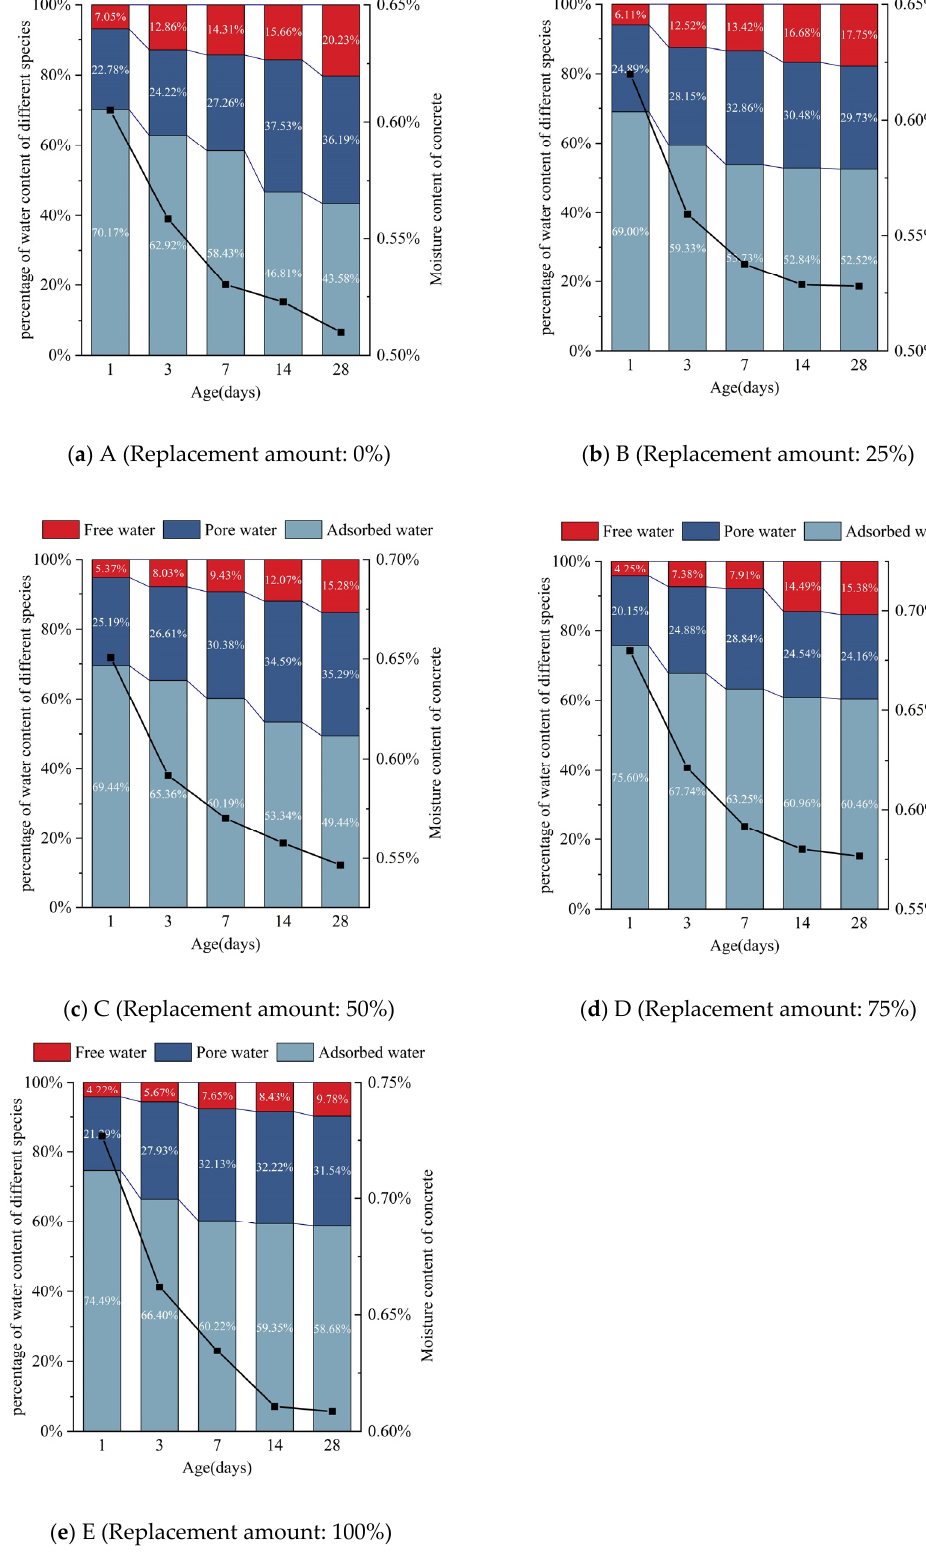
Figure 8. Different forms of water content and total water content in concrete of different ages: ( a ) A (Replacement amount: 0%); ( b ) B (Replacement amount: 25%); ( c ) C (Replacement amount: 50%); ( d ) D (Replacement amount: 75%); ( e ) E (Replacement amount: 100%).